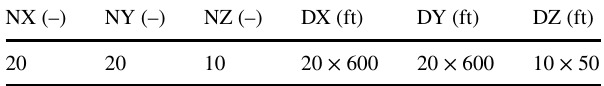
Table 2 Input data for gridding of case#1